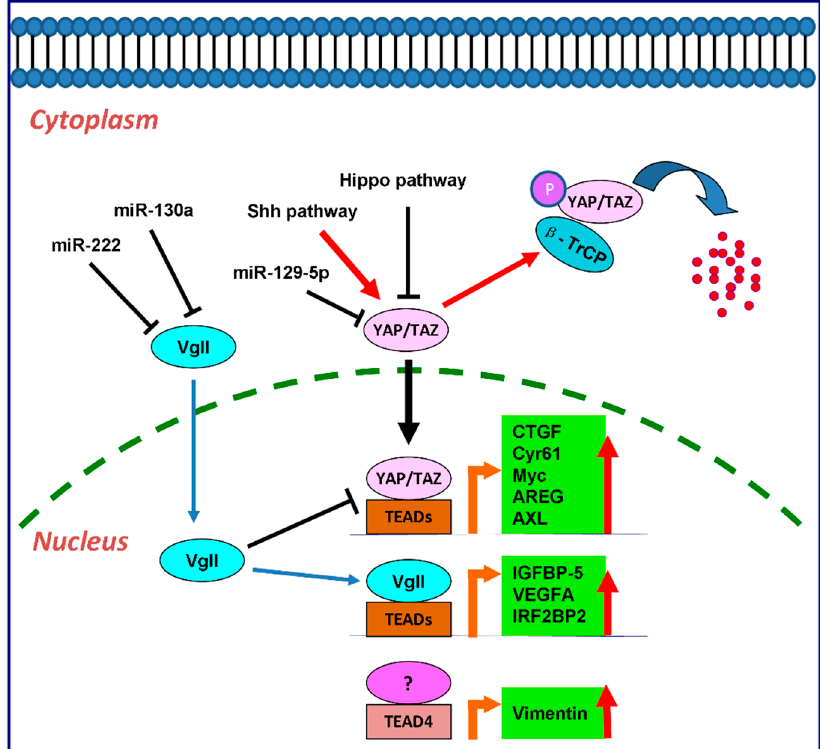
Figure 1. The regulatory cascade of TEAD family in cancer cells as transcription factors. YAP/TAZ, vgll, and p160 family proteins are the main binding partners for TEADs to activate the downstream transcription as transcription co-activators. CTGF , Cyr61 , Myc , AREG and AXL are the downstream targets of YAP and TAZ by interaction with TEADs. vgll directly regulates the expression of IGFBP-5 , VEGFA and IRF2BP2 through TEADs. In colon cancer, TEAD4 also regulates Vimentin expression in a YAP-independent manner.